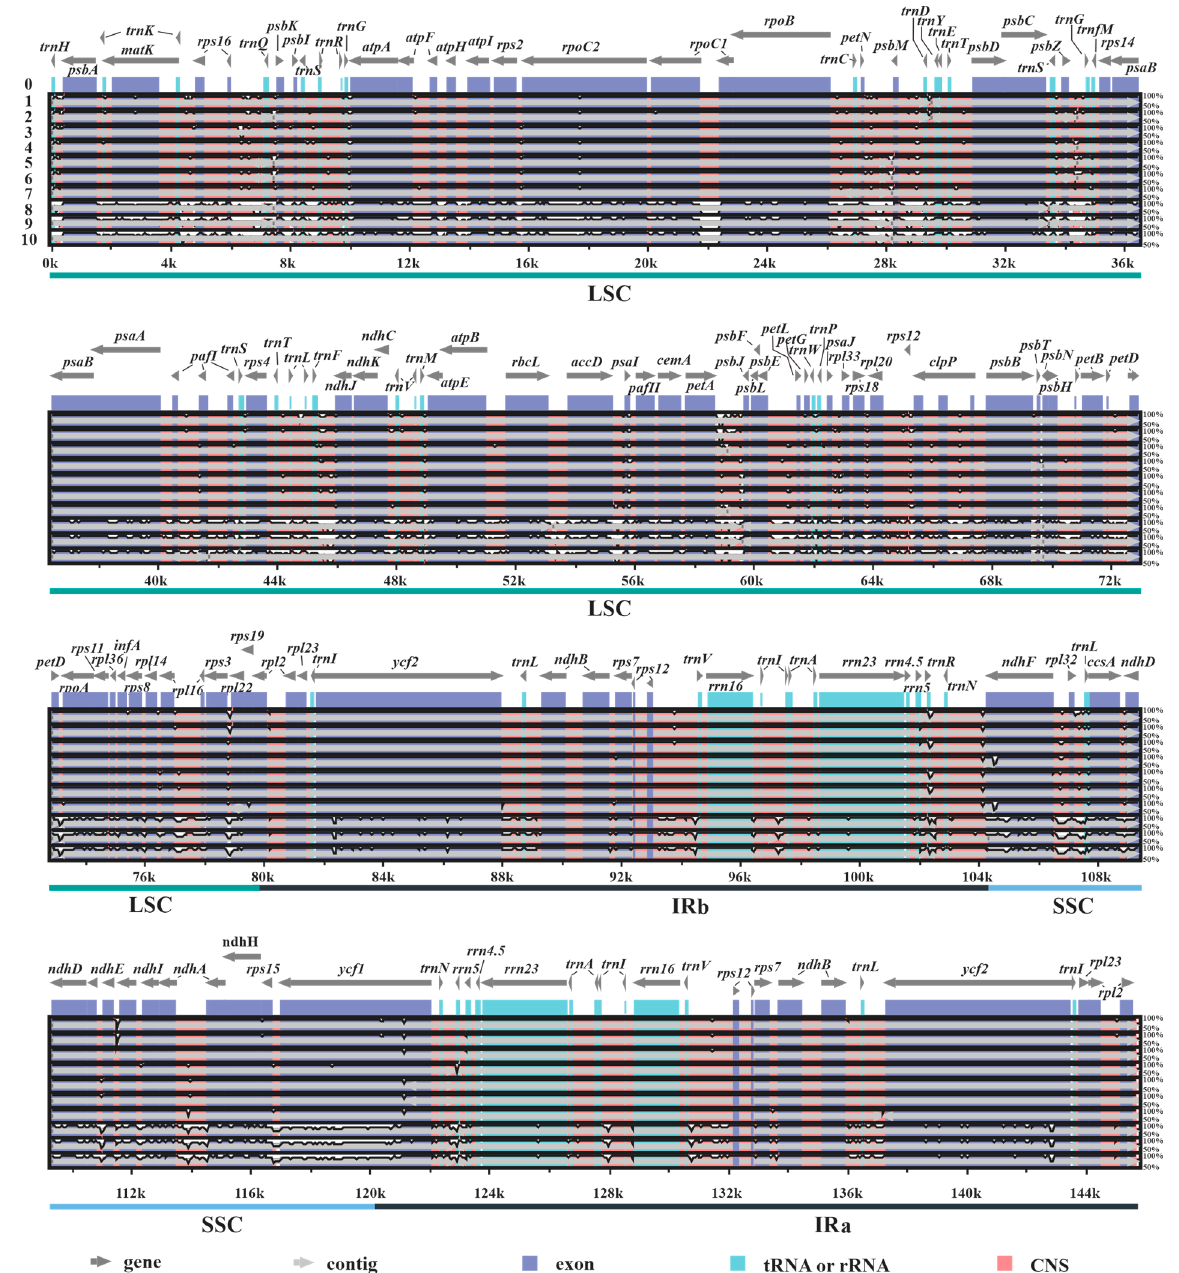
Figure 2. Structure comparisons of ten new Crassula plastomes using the mVISTA program. Y-scale represents the percent identity between 50% and 100%. The labels 0 to 10 indicate C. perforata (reference), C. alstonii , C. columella , C. dejecta , C. mesembryanthoides , C. tecta , C. mesembrianthemopsis , C. socialis , C. volkensii , C. expansa subsp. fragilis , and C. deltoidei , respectively.